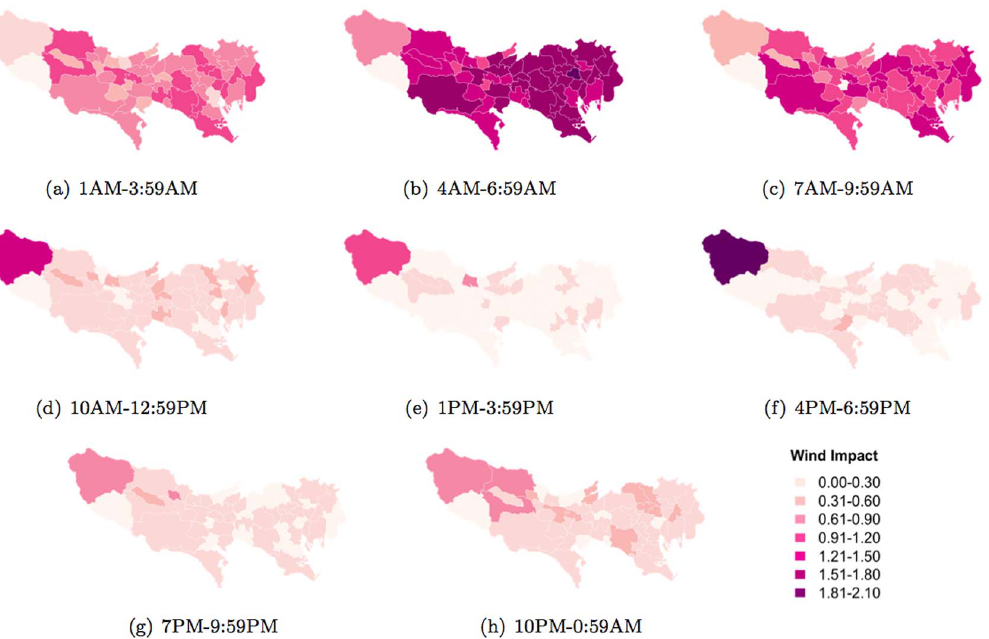
Figure 17. Wind impact (change in entropy between normal and abnormal temperatures) on daily activity patterns across different municipalities.